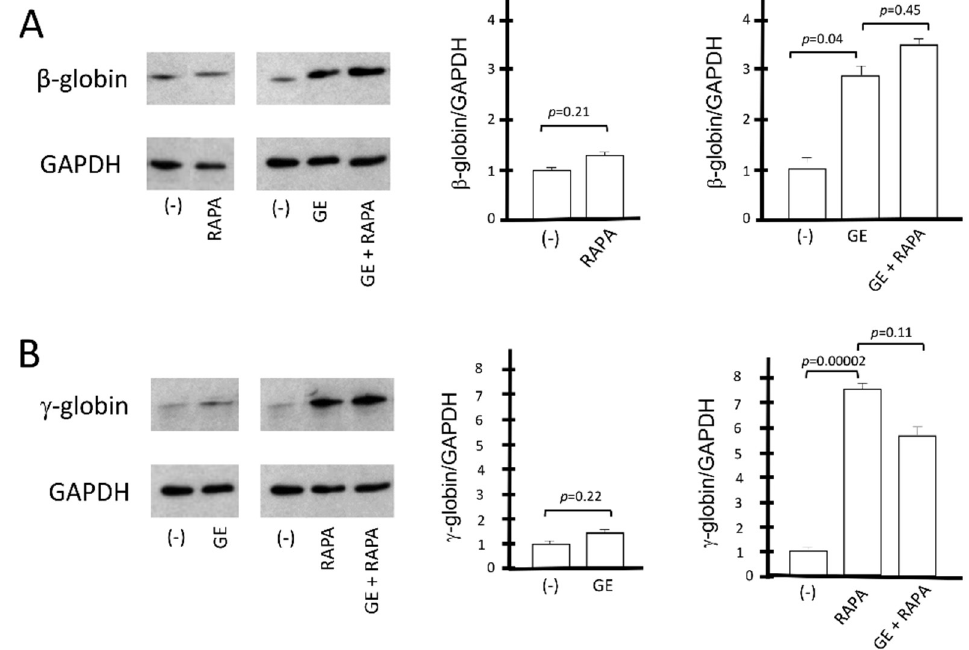
Figure 4. Western blotting analysis of β -globin protein and γ -globin protein. The relative content of β-globin (16 kDa) and γ-globin (15 kDa) proteins was determined by Western blotting analysis, after comparison with the housekeeping GAPDH (37 kDa) protein. ( A ) The effect on β-globin production of the β 0 39 CRISPR-Cas9 system is shown as representative data and graphically reported in the form of gel bands (panel ( A ), left). These results are reported in the right part of panel ( A ) as values of the densitometric analysis with respect to the reference protein GAPDH. ( B ) Representative data graphically show the impact of the β 0 39 CRISPR-Cas9 system on γ-globin expression. For the same samples, the data obtained from densitometric analysis of the Western blotting bands normalized on the housekeeping protein GAPDH (panel ( B ), left) are reported, and statistical significance is indicated as p -value ( p ). (−): untreated cells; GE (cells treated with the CRISPR-Cas9 system), RAPA (rapamycin 200 nM) and GE + RAPA (cells treated with the CRISPR-Cas9 system and then cultured in the presence of rapamycin). The original uncut versions of the gels are shown in Figure S6.